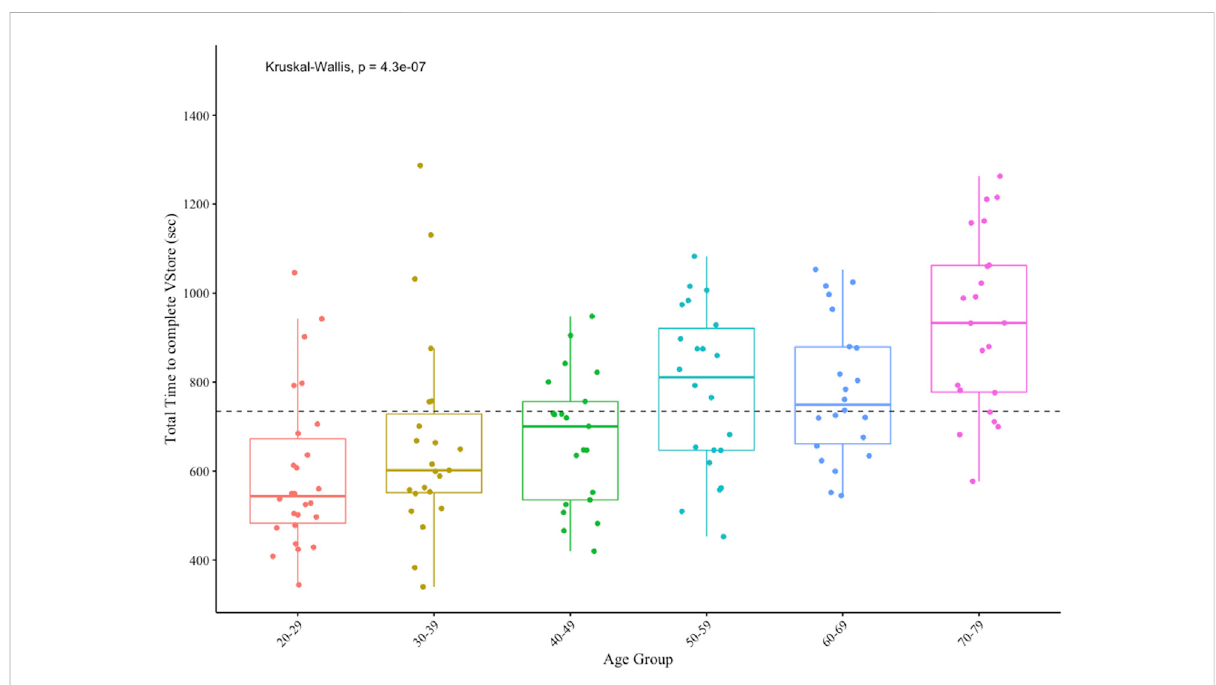
FIGURE 6 Study 1 group differences in VStore Total Time performance.